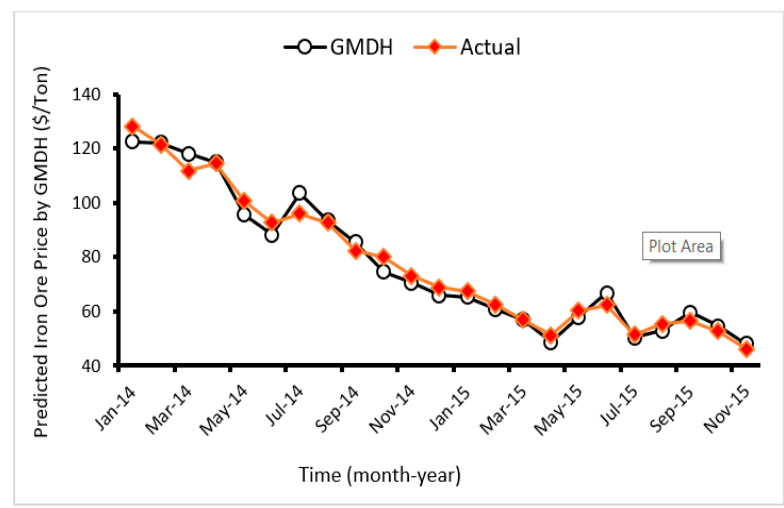
Figure 13. Comparison between the measured and the predicted by SVR model for test stage.